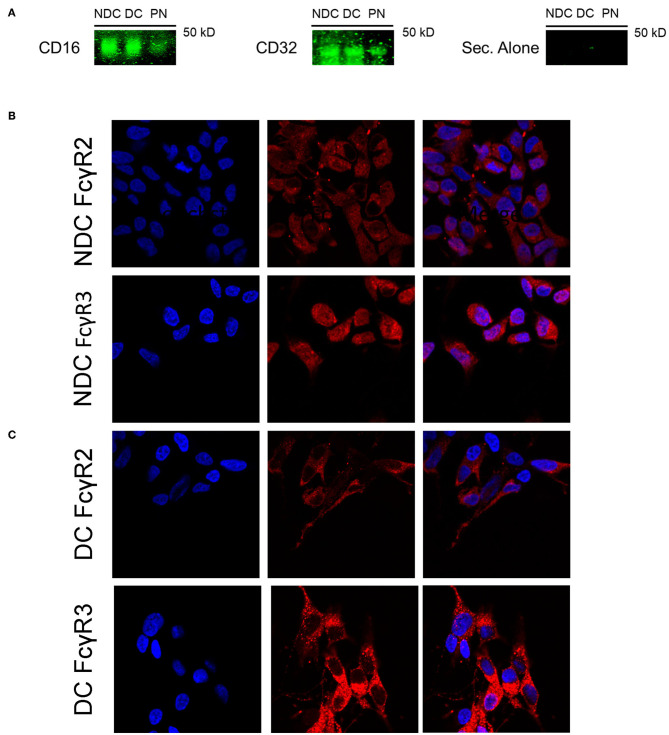
Subtypes of Fcγ receptors are expressed in NDC and DC. Cells were evaluated for presence of FcRs via Western blot and immunohistochemistry. All cells were kept at basal conditions. For Western blot, cells were lysed and equal amounts of protein were added to immunoprecipitation (IP) beads bound to an anti-mouse CD16/32 antibody. Following IP, the samples were subjected to immunoblotting, and the blots probed with antibodies recognizing CD16 and CD32, or fluorescent secondary alone (Sec. Alone). (A) Using both antibodies, the signal is similar in the undifferentiated and differentiated neuroblastoma cells. A band is visible in the lane containing primary neuron samples indicating the presence of receptors on these cells. No signal was visible when the blot was probed with only the fluorescent secondary antibody. For immunohistochemistry, cells were fixed, washed, stained for surface bound Fcγ receptors (FcγR); CD16 (FcγR3) and CD32 (FcγR2), and then imaged using confocal microscopy. Cell images were enlarged further 4x from original file size. (B,C) Analysis of images revealed diffuse staining of both FcγR in or near the soma for DC and NDC. DC showed staining as well in distal processes and neurites, which are not developed in NDC.